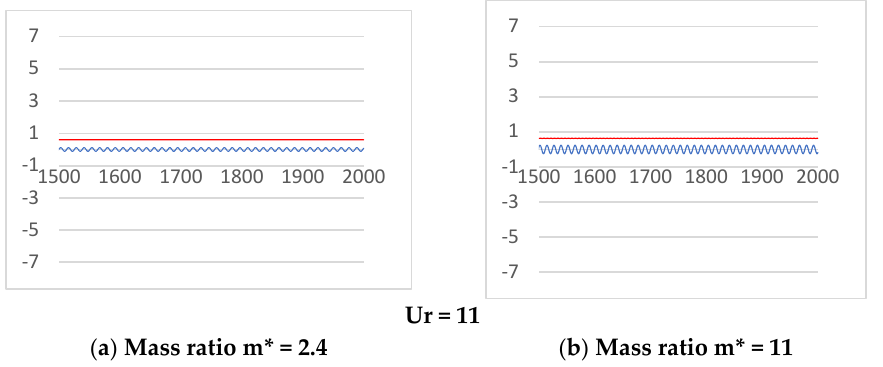
Figure 7. Force coefficients Cd (Red) and Cl (Blue) at difference reduced velocities with surface roughness Ks = 0.02 D: ( a ) mass ratio m* = 2.4 and ( b ) mass ratio m* = 11.